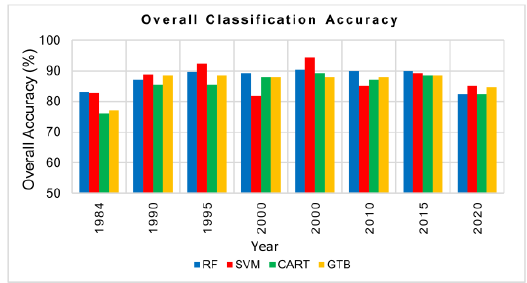
Figure 11 . Average overall accuracy performance of the classifiers.